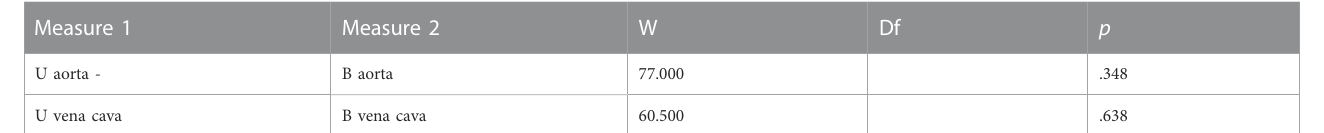
TABLE 3 Wilcoxon Signed-rank test.